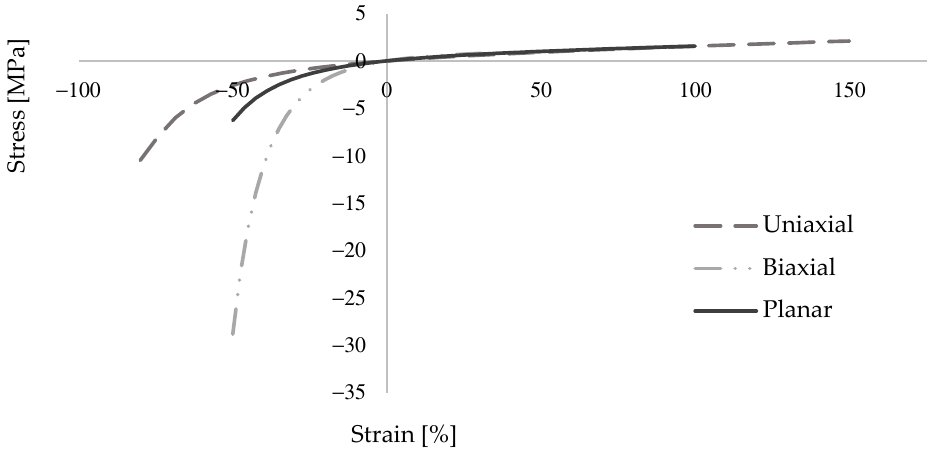
Figure 8. PolyUrethane PM test results from Kisiel [55]. Numerical models were created for representing the three-dimensional structures.